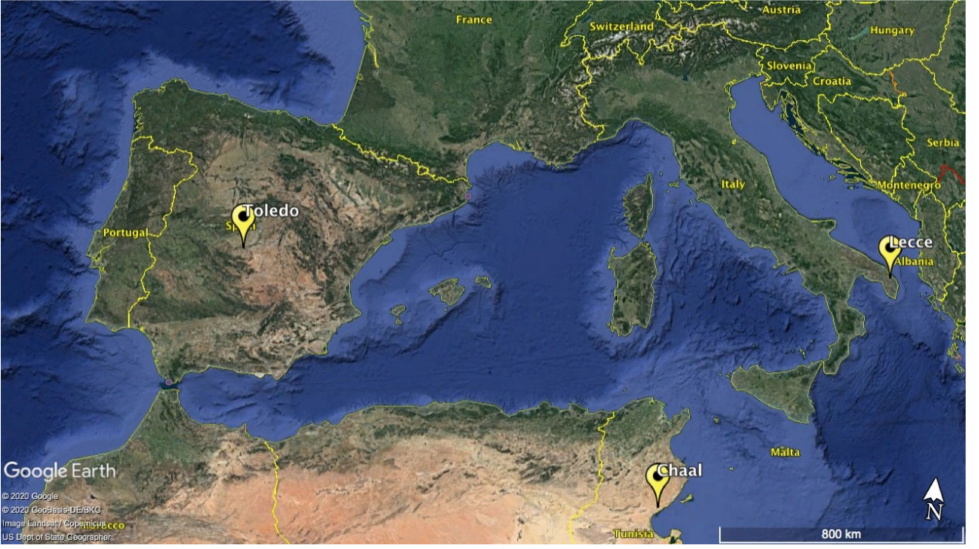
Figure 1. Location of the sampling stations (source: Google Earth ©